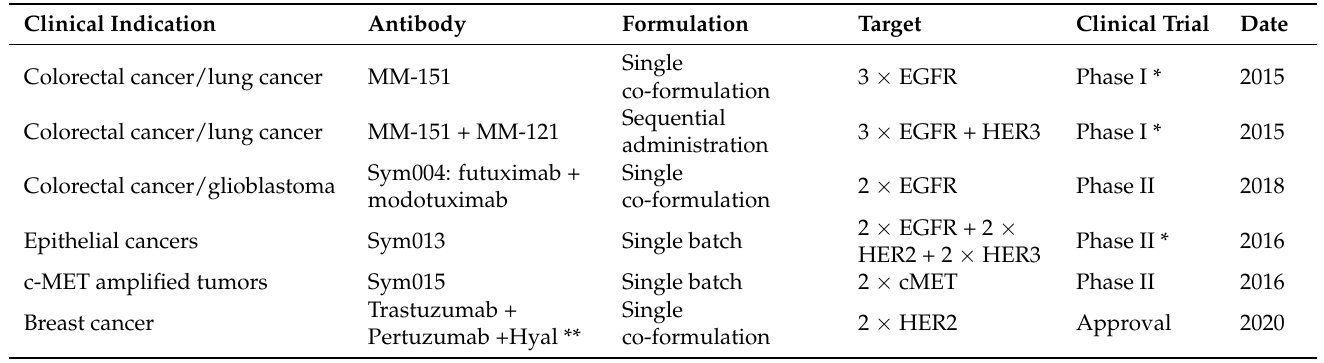
Figure 2. Different strategies to produce a biologic as a drug product (DP) that is a mixture of two antibody drug substances (DS). The single-cell manufacturing allows a mixture of mono- and bi-specific antibodies to be produced. Ab: antibody. Table 2. Antibody mixtures in